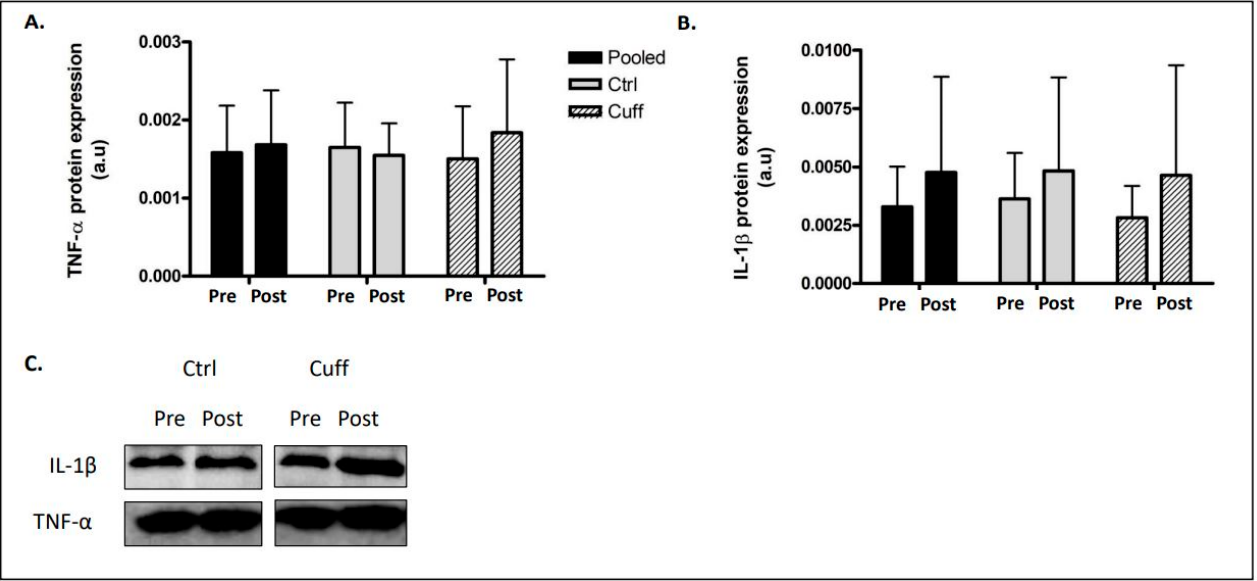
Figure 8. Effect of 5 days of DI on muscle inflammation process. Inflammation activation evaluation by western blot analysis. ( A ) TNF- α protein expression. ( B ) IL-1 β protein expression. ( C ) Western blot picture analysed by groups. * different from pre values in the same matched paired group analysis.